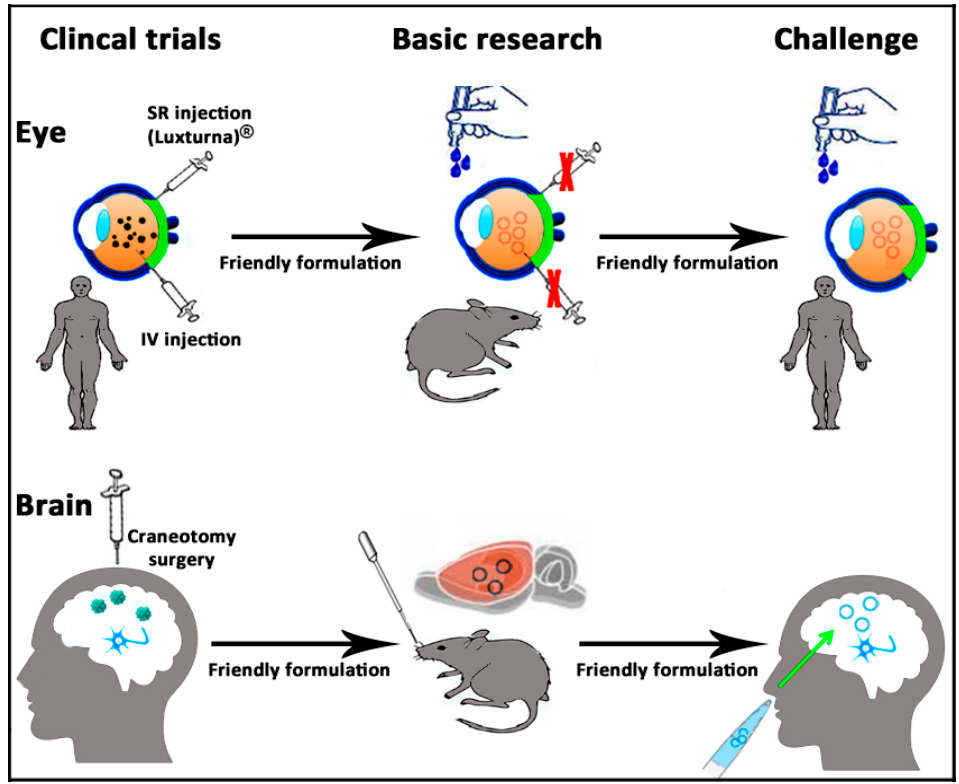
Figure 8. Schematic representation of a gene therapy approach based on non-viral vectors and non-invasive administration route to face brain and eye diseases.